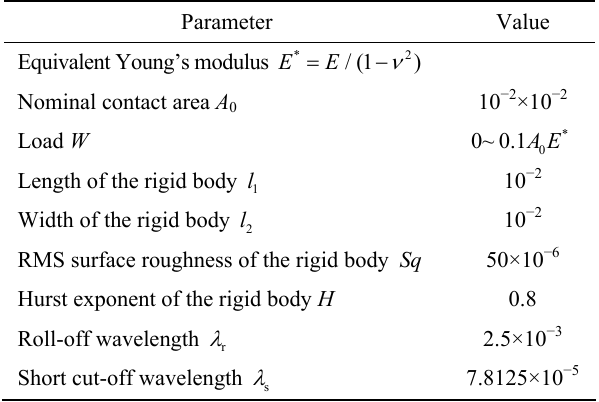
Length of the rigid body l 10 − 2 1 l 10 − 2 Width of the rigid body 2 RMS surface roughness of the rigid body Sq 50×10 − 6 Hurst exponent of the rigid body H 0.8 Roll-off wavelength  2.5×10 − 3 r Short cut-off wavelength s